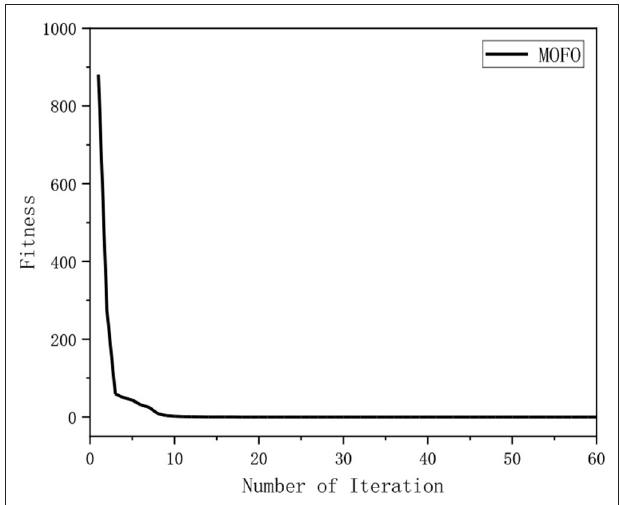
FIGURE 11 | The stability of different